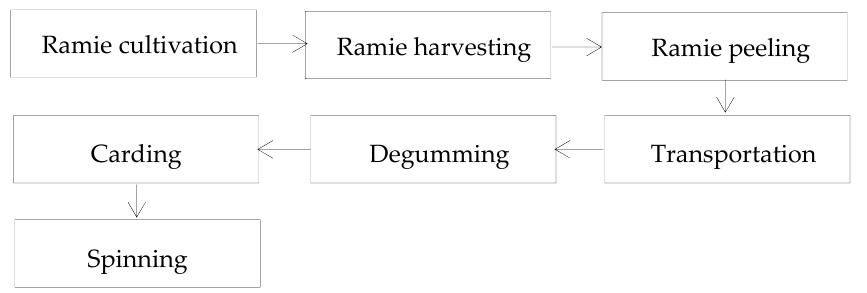
Figure 1. Production processes of ramie fiber.